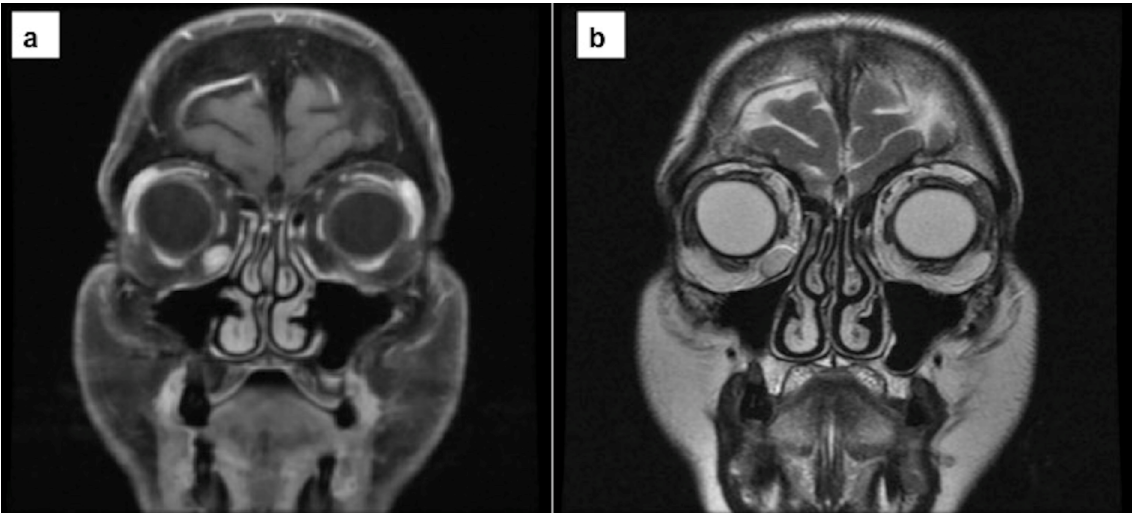
Figure 1: Magnetic resonance imaging of the coronal section. a) MRI – T1 gadolinium-enhanced showed a well-defined lesion in the inferior orbital rim that was enhanced with contrast. b) MRI – T2 showed a hyperintense lesion. The capsule is shown as well as low-intensity septation.